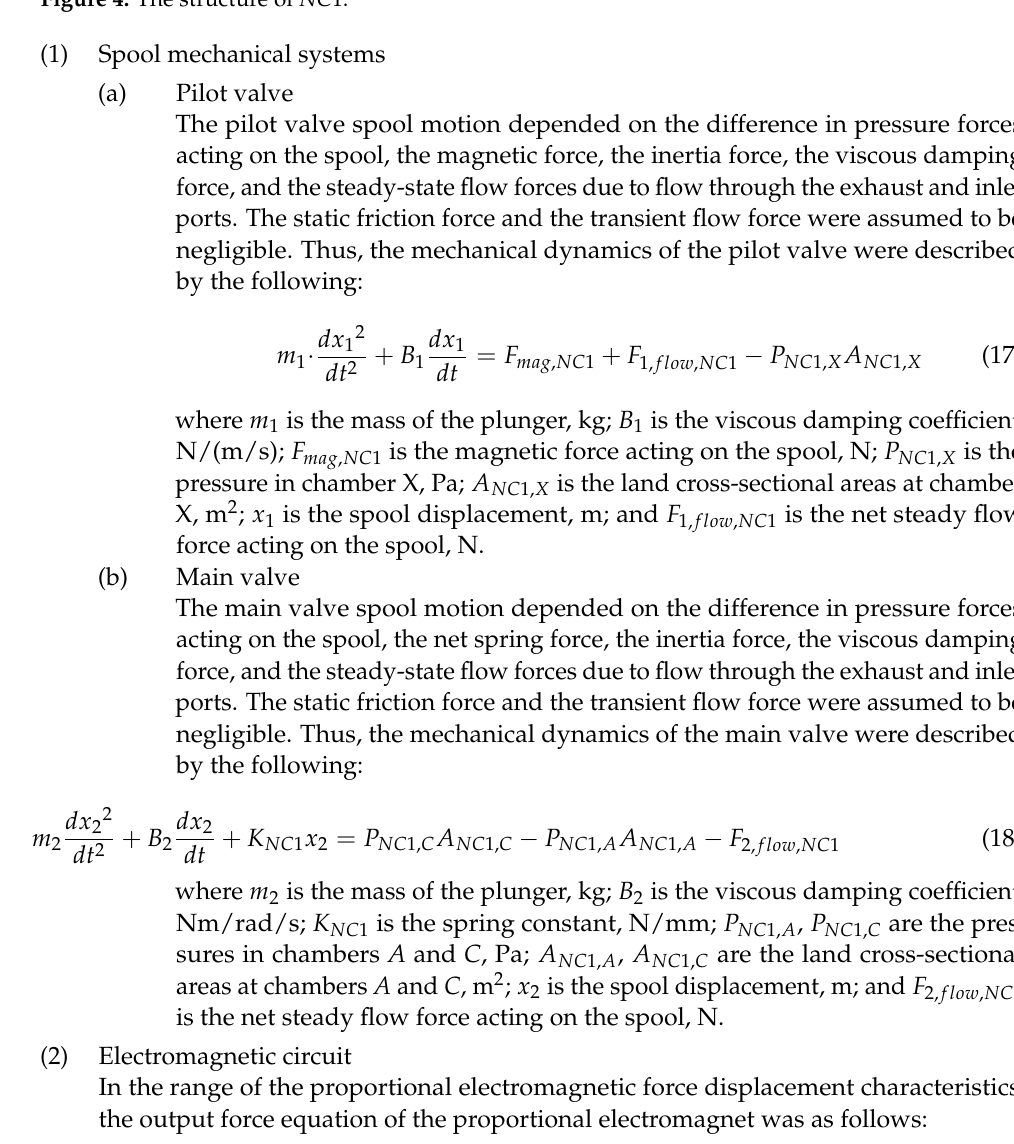
Figure 4. The structure of NC 1.